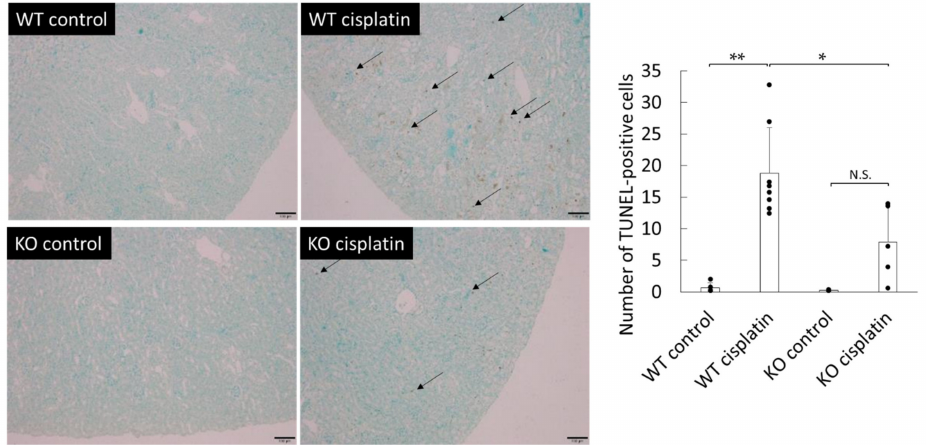
Figure 3. Detection of TUNEL-positive cells in the kidney of WT and Sult1a1 -/- (KO) mice: the arrows indicate typical apoptotic cells. Scale bar, 100 µ m. Each column represents the mean ± S.D. of 4–8 mice. * p < 0.05; ** p < 0.01; N.S., not